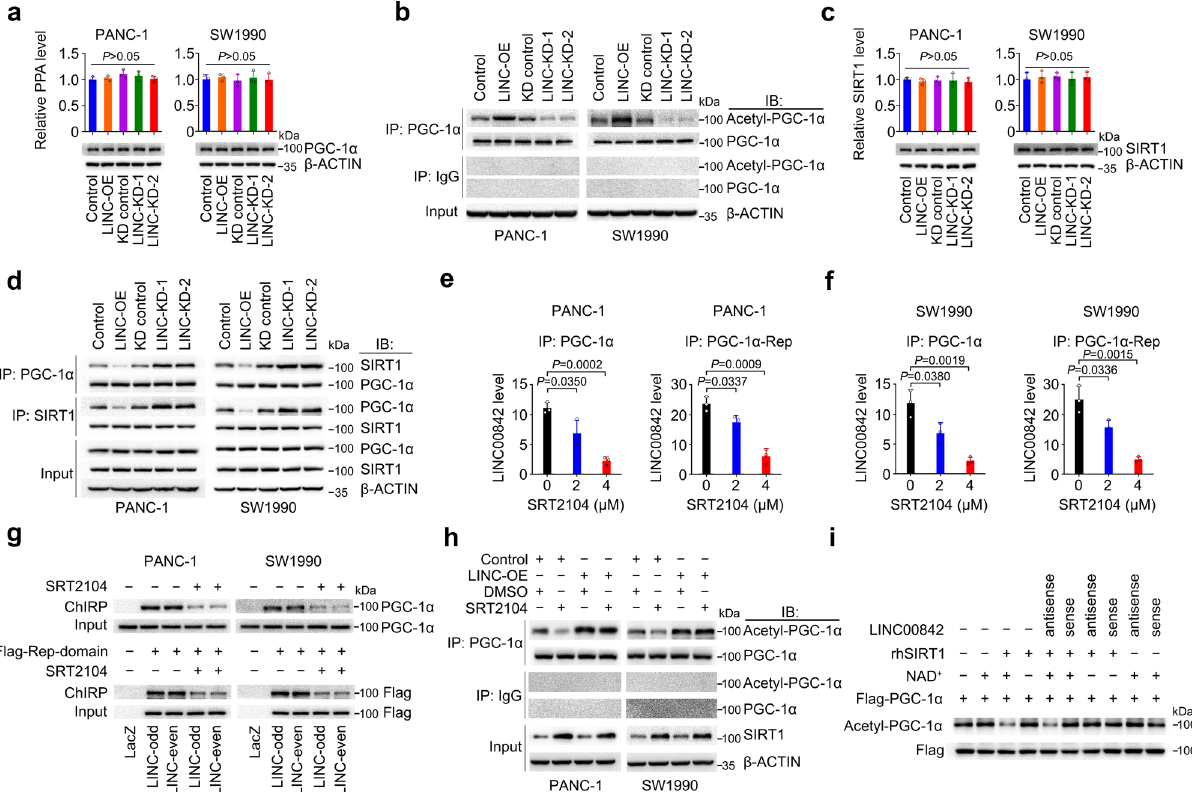
Fig. 5 LINC00842 reduces deacetylation of PGC-1 α by SIRT1 in PDAC cells. a LINC00842 overexpression (LINC-OE) or silence (LINC-KD) did not affect PPARGC1A (PPA) mRNA and protein levels. b LINC00842 expression change altered acetylated PGC-1 α (acetyl-PGC-1 α ) levels. c LINC00842 expression change did not affect SIRT1 mRNA and protein levels. d Reciprocal immunoprecipitation assays show inhibitory effect of LINC00842 on the interaction of PGC-1 α with SIRT1. e , f Effect of SIRT1 agonist SRT2104 on the interaction of PGC-1 α or its Repression domain (PGC-1 α -Rep) with LINC00842 . The level of LINC00842 RNA in RNA immunoprecipitation product decreased in a SRT2104 dose-dependent manner. g Results of chromatin isolation by RNA puri fi cation (ChIRP) assays using LINC00842 -odd, -even or LacZ (negative control) antisense probe sets. SRT2104 treatment reduced the interaction of PGC-1 α or its Repression domain with LINC00842 . h Immunoprecipitation and immunoblotting assays show inhibitory effect of LINC00842 on PGC-1 α deacetylation by SRT2104 (4 µ M). i Effects of LINC00842 sense or antisense on in vitro PGC-1 α -Lys deacetylation by recombinant human SIRT1 (rhSIRT1) in the presence or absence of NAD + , showing only LINC00842 sense inhibited the deacetylation. Flag was blotted as a loading control. The immunoblots in ( g – i ) are representative results from 3 independent experiments with similar results. The results shown in ( a ), ( c ), ( e ), and ( f ) are mean ± SD from 3 independent experiments. The P values were determined by Student ’ s t -test